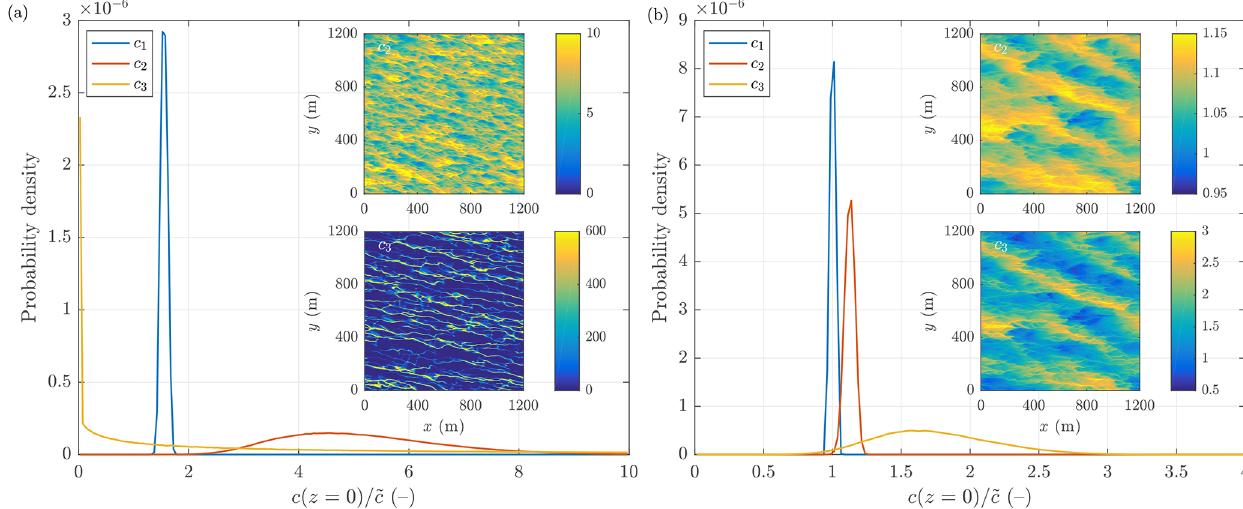
Figure 7. Distribution of frazil at the sea surface in simulations with (a) U a = 5ms − 1 and T a = − 1 . 5 ◦ C and (b) U a = 30ms − 1 and T a = − 20 ◦ C. The main plots show probability distributions of frazil volume fraction (normalized with ˜ c ) at the surface ( z = 0) for all three size classes. All curves shown integrate to the value of 1. The insets show snapshots of c i / ˜ c i for i = 2 (top) and i = 3